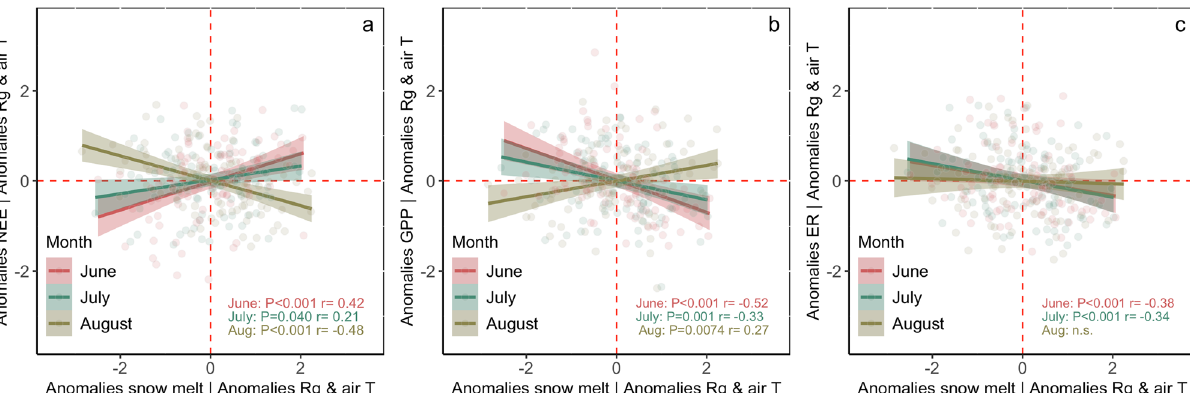
Figure 2. Relationships between the indicated median monthly anomalies using partial correlation analysis accounting for solar radiation and air temperature anomalies (retaining site as the unit of variation). Given that the interaction term between “month” and snowmelt timing was significant, we included the correlation coefficients and P of the regressions for each of the indicated months separately in each panel (also included in Table 1). Negative values indicate CO 2 uptake and positive values CO 2 release into the atmosphere, and shaded areas are 95% confidence intervals.